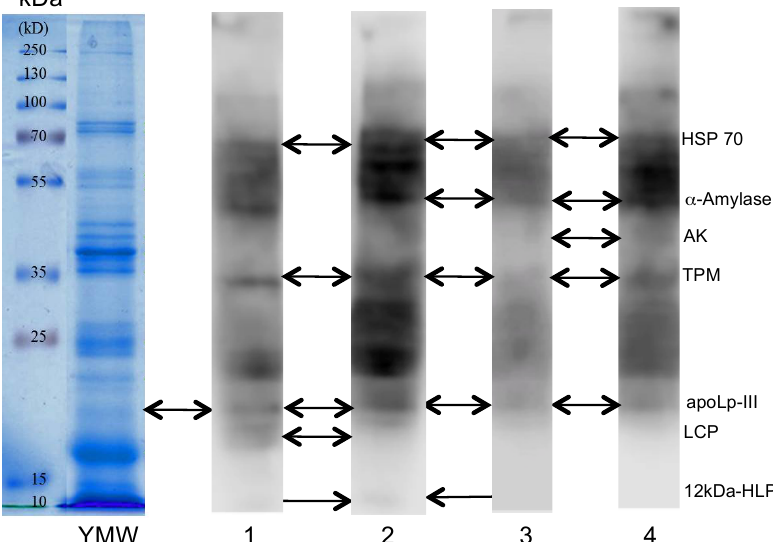
Figure 2. SDS-PAGE of the yellow mealworm (second line labelled, YMW). The first line corresponds